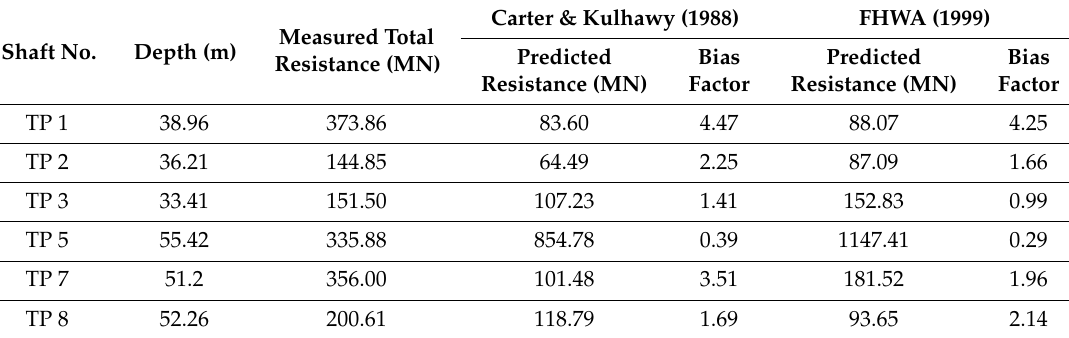
Table 8. Calculated bias factors for total resistance.